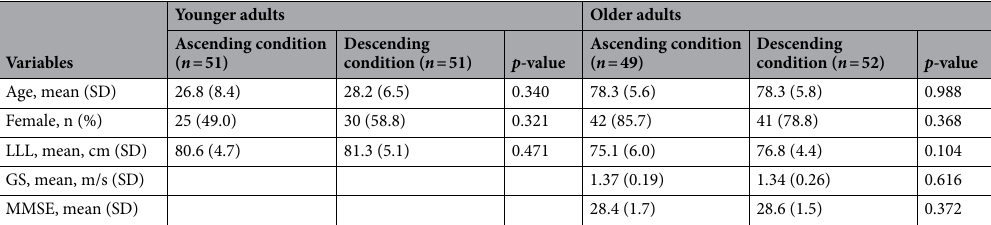
Table 1. Participant characteristics. LLL length of lower limb, GS gait speed, MMSE Mini-Mental State